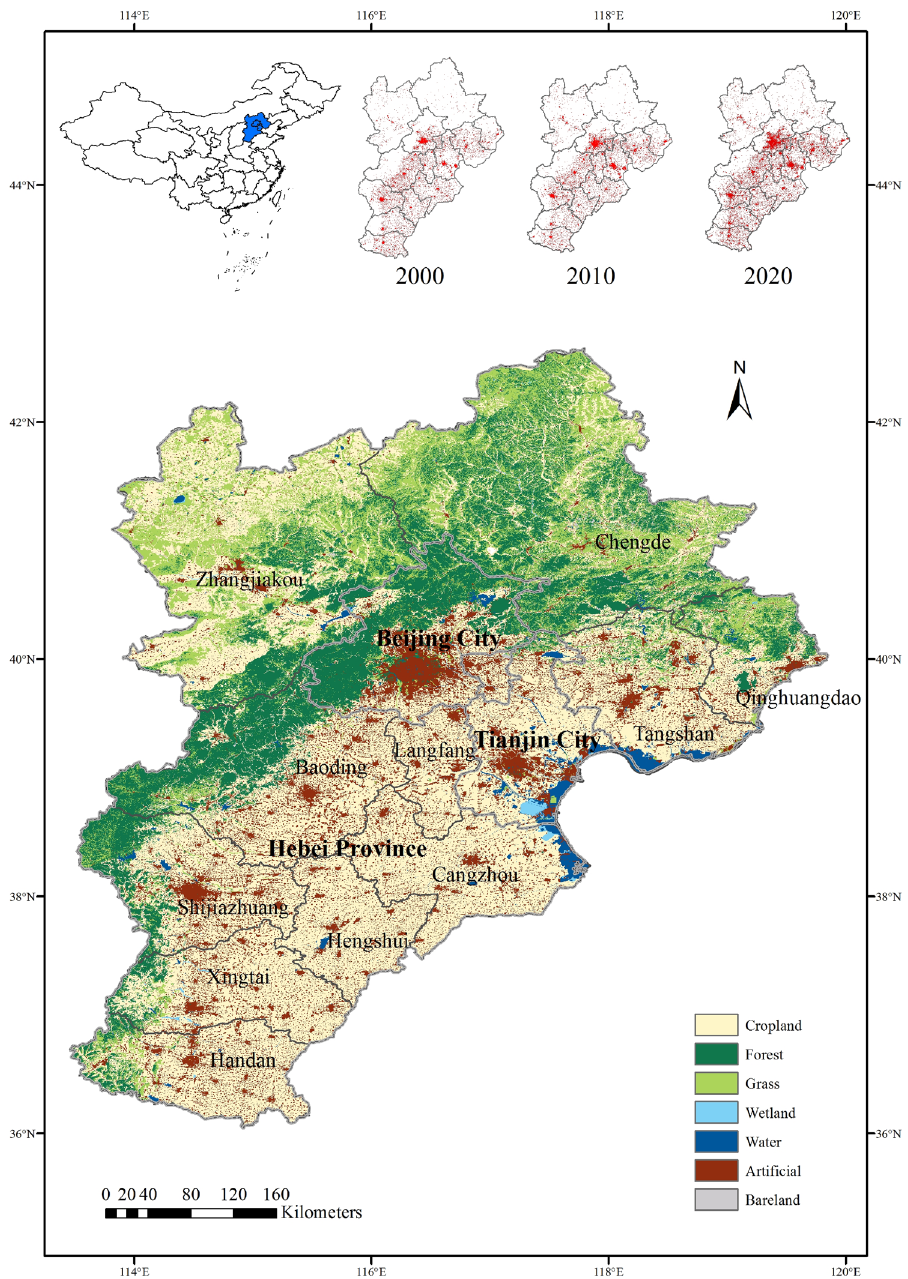
Figure 1. Location and land cover of the study area. The land cover map was extracted from Globeland30 dataset provided by National Geomatics Center of China in 2020. The maps were created using ArcGIS 10.2 (http:// www. esri. com/ softw are/ arcgis/ arcgis- for- deskt